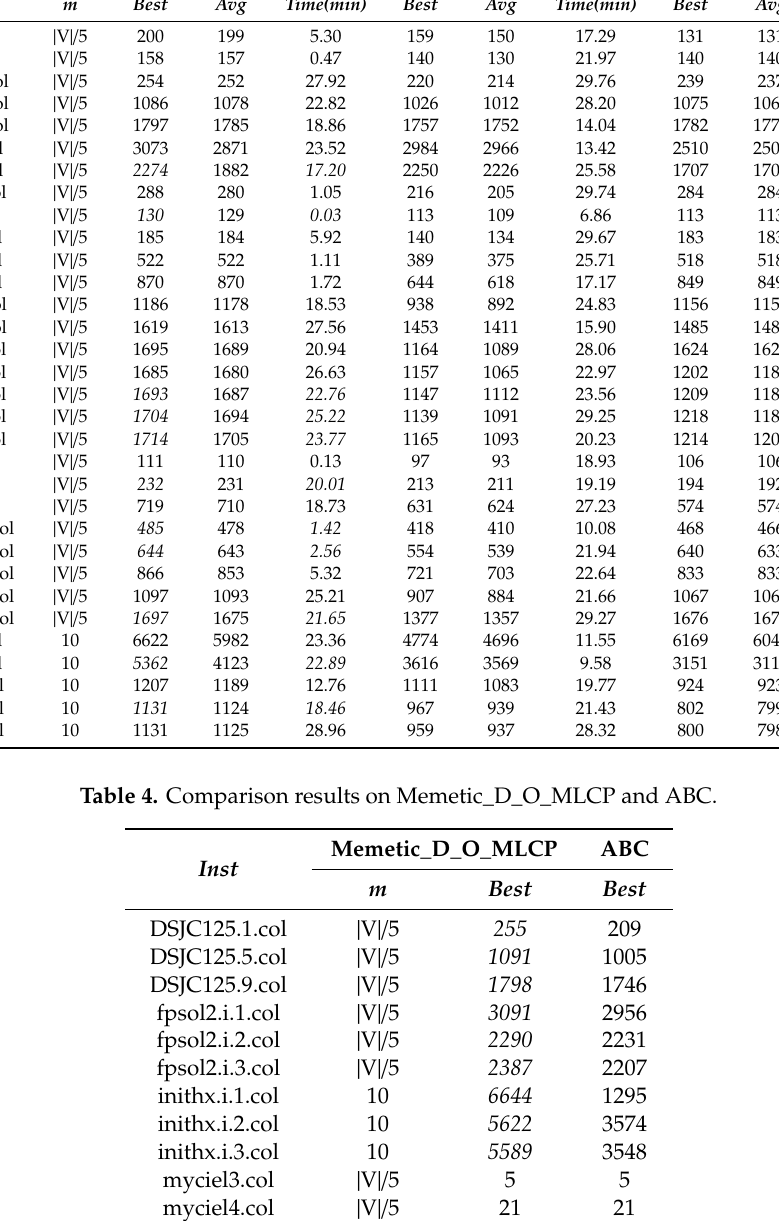
Table 3. Running time of the Memetic_D_O_MLCP, SA and Greedy on benchmark instances. Inst anna.col